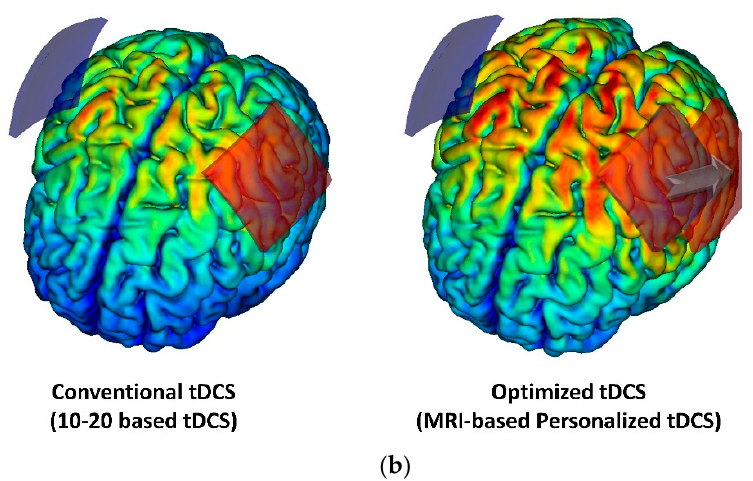
Figure 3. ( a ) The intervention methods for the three groups. ( b ) Computational results of the opti- mized and conventional tDCS